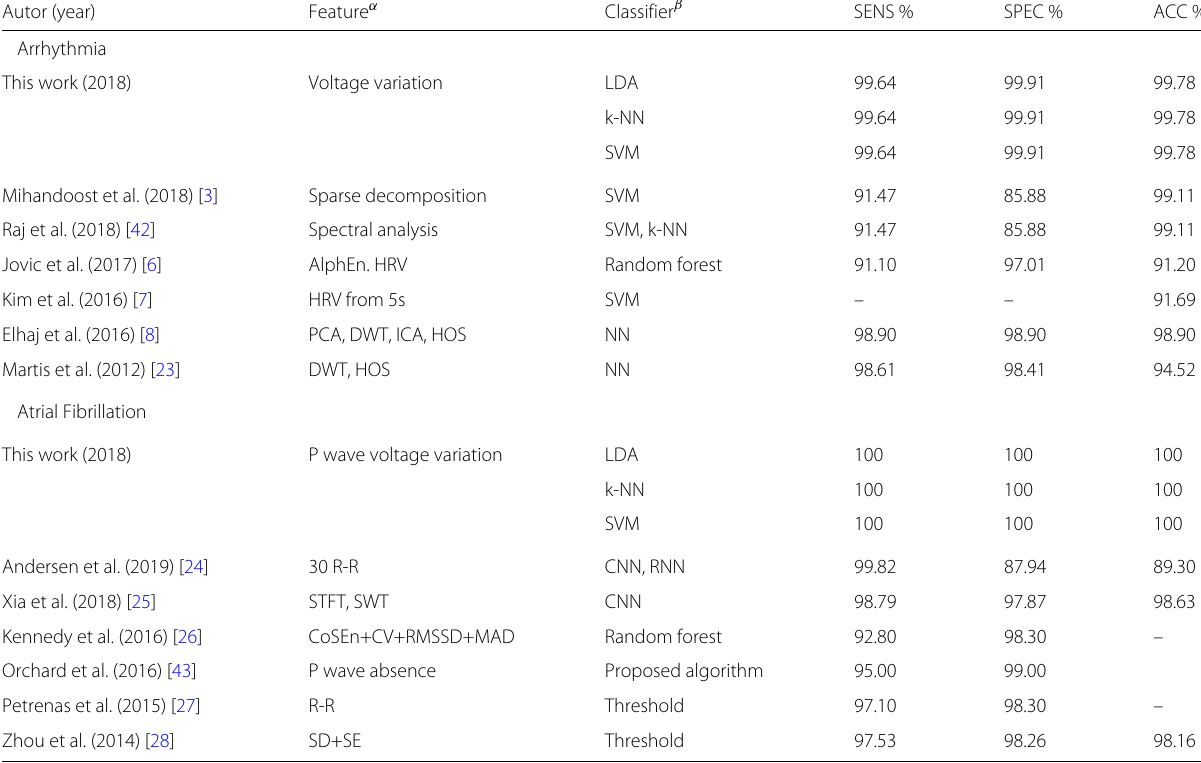
Table 4 Sensitivity, specificity, and accuracy of the proposed methodology compared to the literature for arrhythmia and AF classification, evaluated for MIT-BIH Normal Sinus Rhyth, MIT-BIH Arrhythmia, and MIT-BIH Atrial Fibrillation